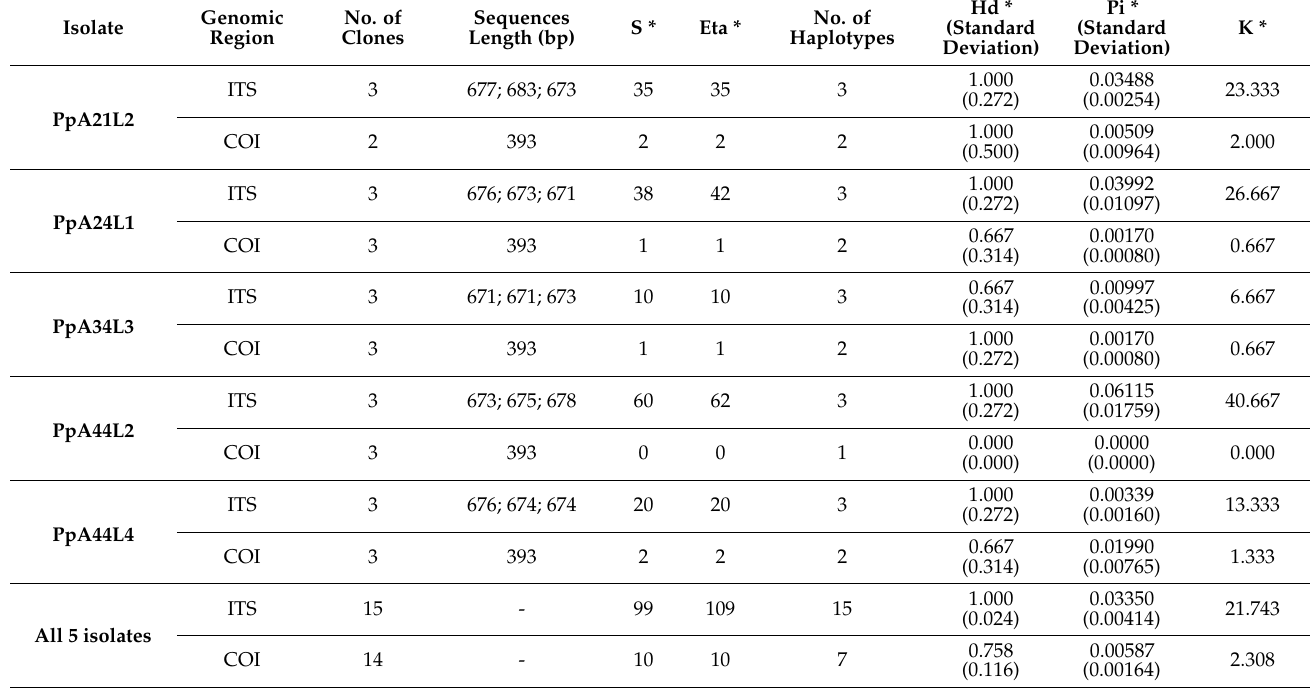
Table 5. Genetic diversity of cloned ITS and COI regions of five Pratylenchus penetrans isolates from Portugal. Genomic Isolate